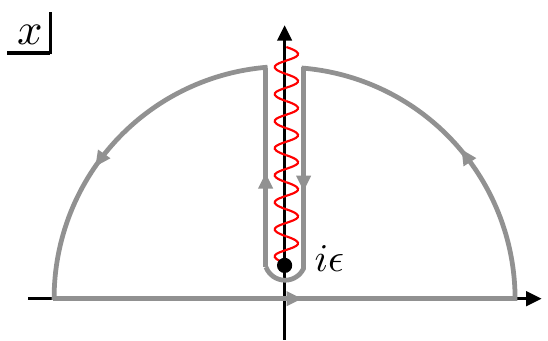
Figure 1 . Integration contour for evaluating eq. (3.4). The i(cid:15) prescription for this Wightman function places the branch point in the upper half of the complex plane, which ensures that the Fourier transform only has support for physical lightcone momentum P > 0. The discontinuity along this branch cut gives the resulting momentum space expression in eq.